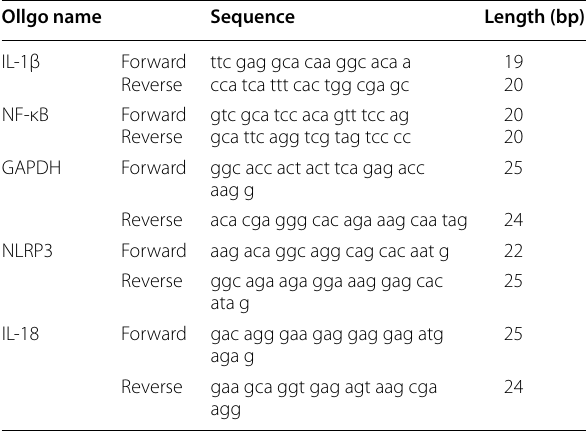
Table 1 Sequence of quantitative real-time polymerase chain reaction